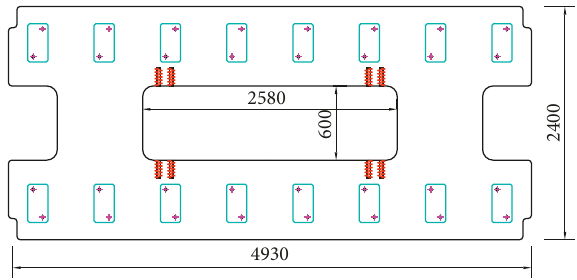
Figure 2: Structure diagram of the precast concrete track